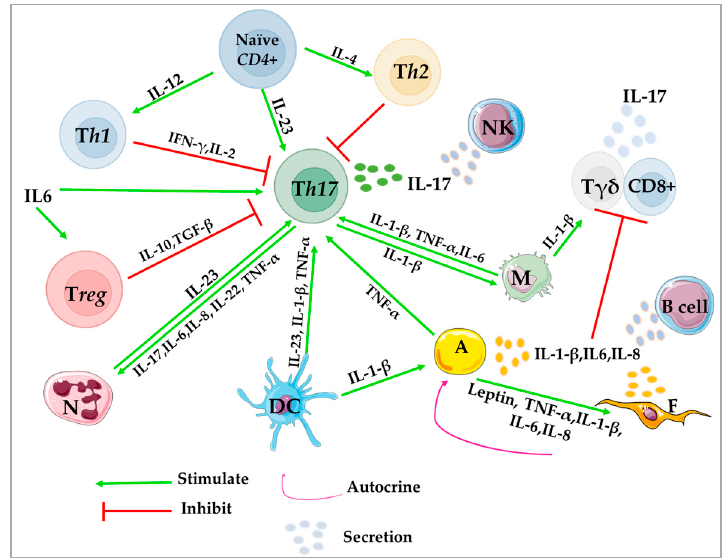
Figure 2. Reciprocal crosstalk and immunoregulation between immune cells, adipocytes, and fibroblasts. DC: dendritic cell; IFN: interferon; IL: interleukin; M: macrophage; N: neutrophil; NK: natural killer cell; Th: T-helper cell; Treg: regulatory T cell; γδ T: gamma delta T cells; Th17: T-helper cell 17; A: adipocyte; F: fibroblast.